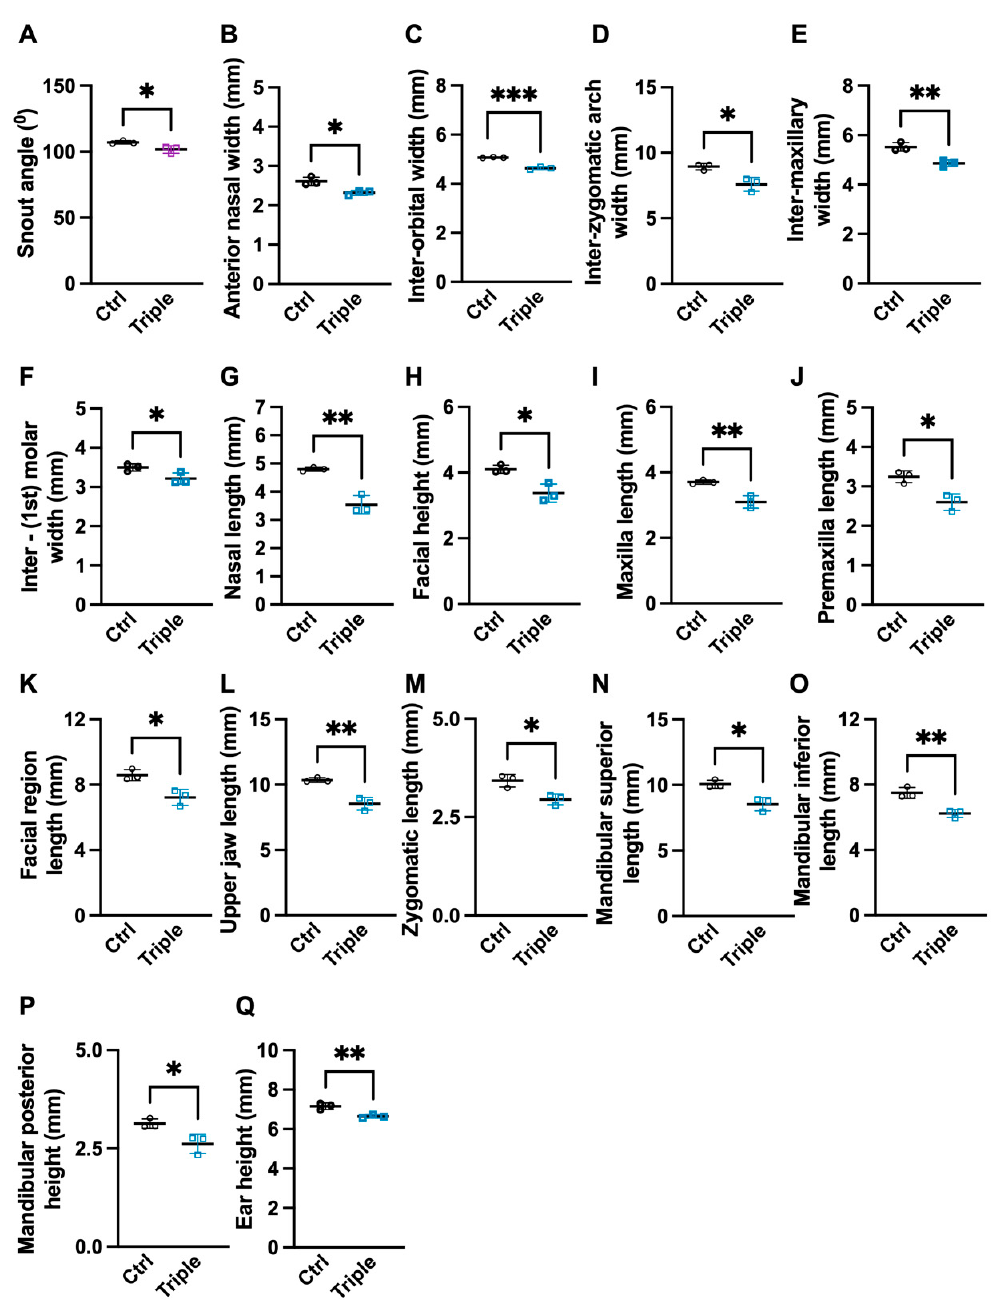
Figure 2. Significantly smaller true measurement differences in Thm2 − / − ; Thm1 aln/+ mice. True measurements of control (Ctrl) and Thm2 − / − ; Thm1 aln/+ (Triple) mutant ( A ) snout angle; ( B ) anterior nasal width; ( C ) inter-orbital width; ( D ) inter-zygomatic arch width; ( E ) inter-maxillary width; ( F ) inter-(1st) molar width; ( G ) nasal length; ( H ) facial height; ( I ) maxillary length; ( J ) premaxillary length; ( K ) facial region length; ( L ) upper jaw length; ( M ) zygomatic length; ( N ) mandibular superior length; ( O ) mandibular inferior length; ( P ) mandibular posterior height; ( Q ) ear height. n = 3 control; n = 3 triple allele mutant. Data points represent individual mice. Bars represent mean ± SD. Statistical significance was determined using unpaired t -tests. * p < 0.05; ** p < 0.01; *** p <